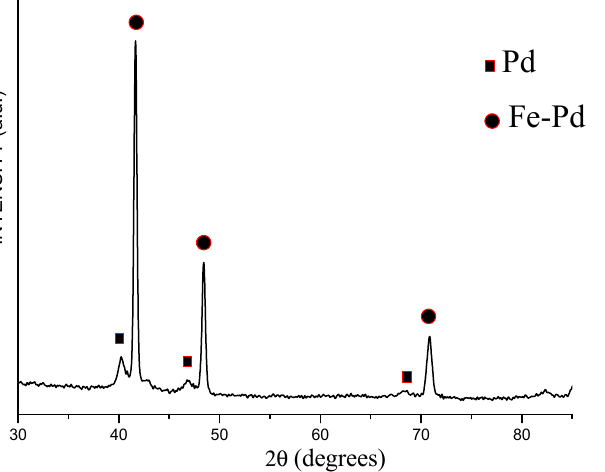
Figure 13. XRD pattern of the annealed powder treated in HCl solution (Fe-Pd is a Fe-rich solid solution).